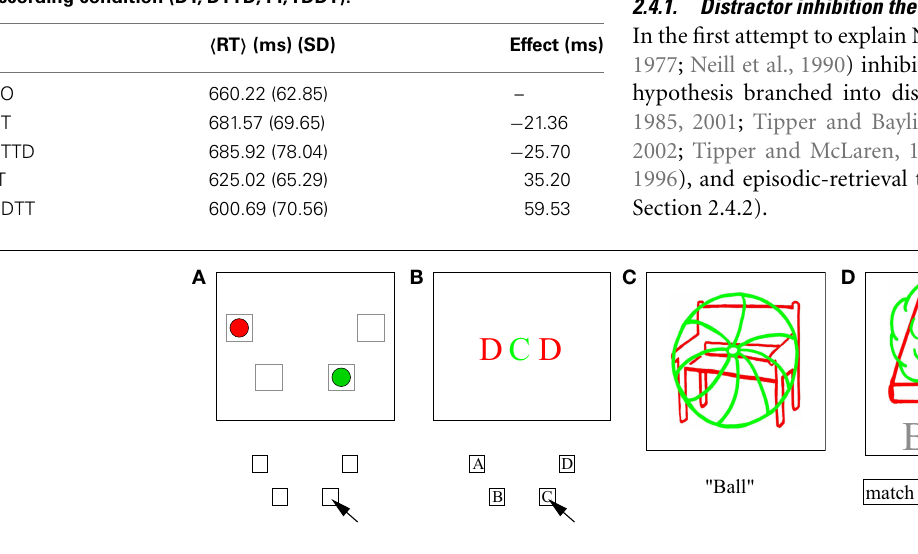
Table 2 | Reaction times, standard deviation, and priming effects, i.e., the differences of control (CO) reaction time and reaction time of the according condition (DT, DTTD,TT,TDDT).